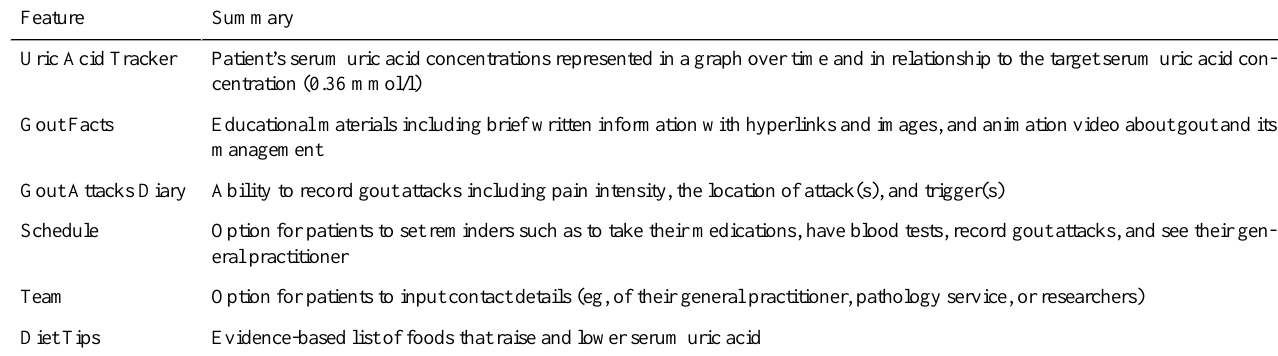
Table 1. Features of Healthy.me